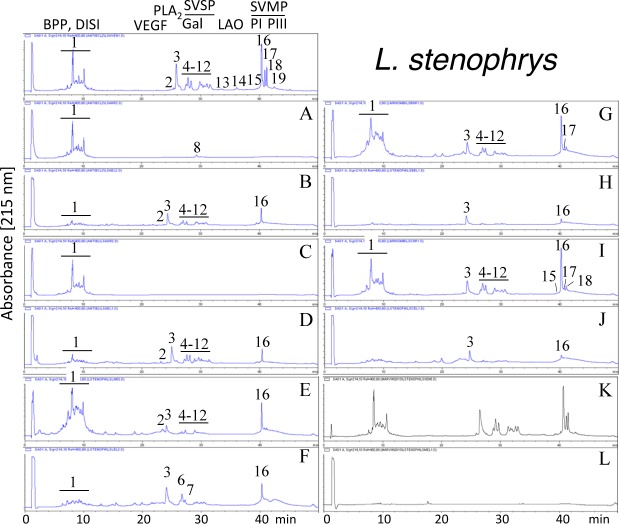
Immunoaffinity chromatography-based antivenomic analysis of the immunoreactivity of polyspecific and monospecific antivenoms towards the venom of L. stenophrys from Costa Rica.Panels display reverse-phase separations of whole venom components, and non-retained (A, C, E, G, and I) and the retained (B, D, F, H, and J) fractions recovered, respectively, from the affinity columns of immobilized BCL, BL, AL, AB, and AC antivenoms. Panels K and L, non-retained and retained venom fractions by immobilized equine control immunoglobulins. BPP, bradykinin-potentiating peptide; DISI, disintegrin; VEGF, vascular endothelial growth factor; PLA2, phospholipase A2; Gal, galactose-binding lectin; SVSP, snake venom serine proteinase; LAO, L-amino acid oxidase; PI and PIII, snake venom metalloproteinase (SVMP) of class PI and PIII, respectively.